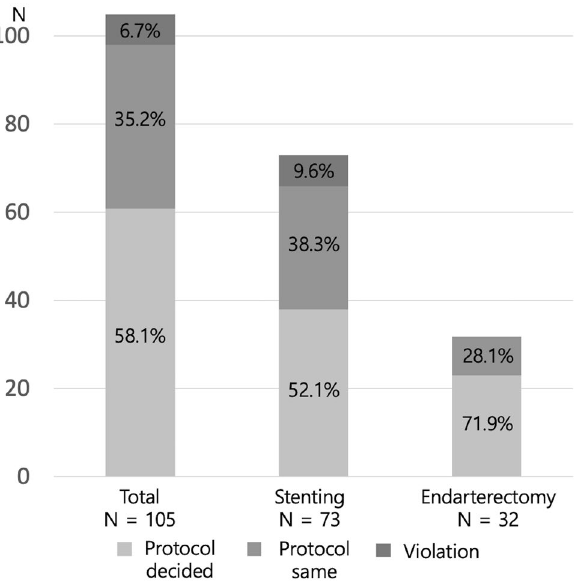
Figure 1. The proportion of treatments applied. A total of 98 (93.3%) patients were treated following protocol. Among them, 61 (58.1%) patients received treatments decided by the protocol. There were violations in seven (6.7%) patients. Although these patients had higher scores for endarterectomy, they all received carotid stenting. There were 37 (35.2%) patients who had equal scores for endarterectomy and carotid stenting also tended to choose stenting over